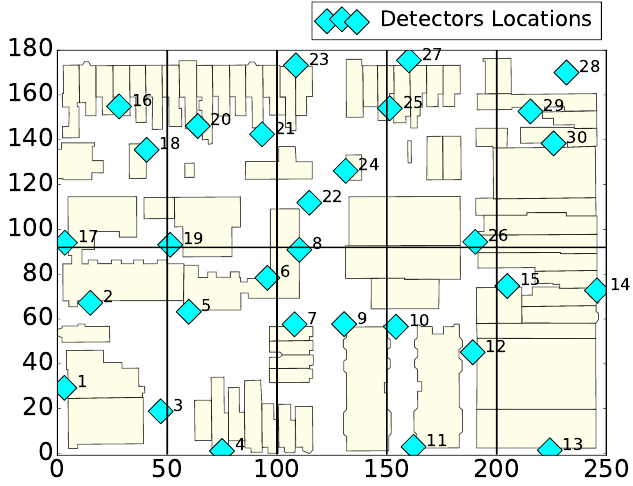
Figure 2. Network formed by 10 sensors with 30 possible